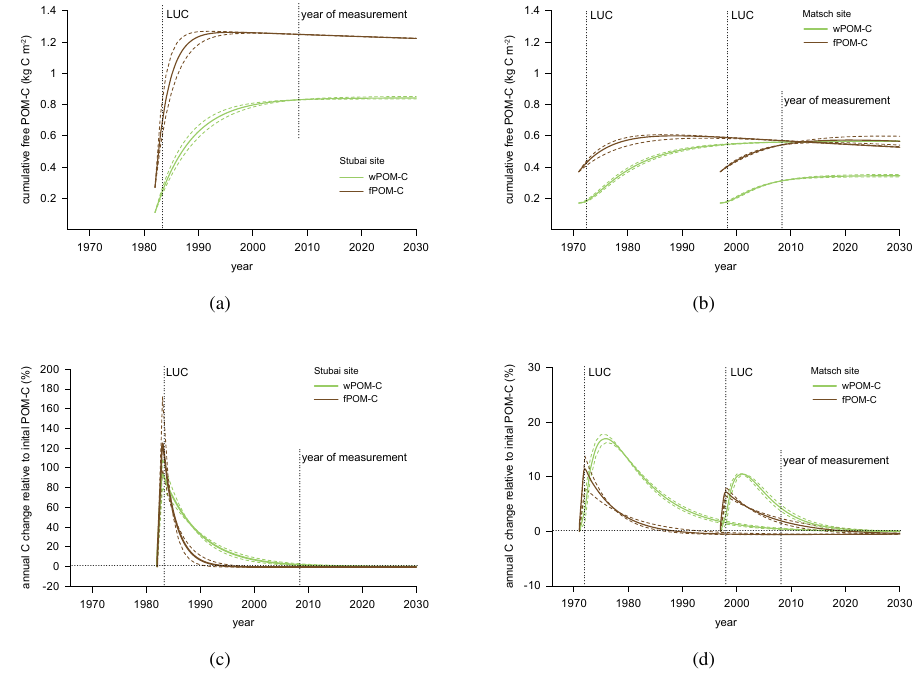
Fig. 2. Carbon (C) accumulation plot of (a) water-floatable (w-) and free (f-) particulate organic matter (POM) in nonsteady state abandoned grassland at the Stubai site from start since land-use change (LUC) in 1983 predicted until 2030 and (b) w- and fPOM-C in nonsteady state pasture and abandoned grassland at the Matsch site from start since LUC in 1972 and 1998 predicted until 2030, respectively. Annual relative change in wPOM-C and fPOM-C since start of LUC in (c) nonsteady state abandoned grassland (1983) predicted until 2030 at the Stubai site and (d) in nonsteady state pasture (1972) and abandoned grassland (1998) predicted until 2030 at the Matsch site. C stock was measured in year 2008. Dashed lines represent 1 σ of radiocarbon measurements.